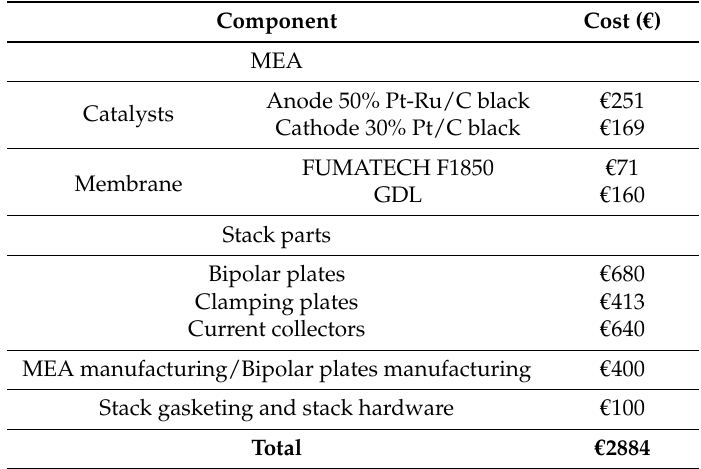
Table 1. Cost estimation for the DURAMET stack prototype produced at a small scale (referred to